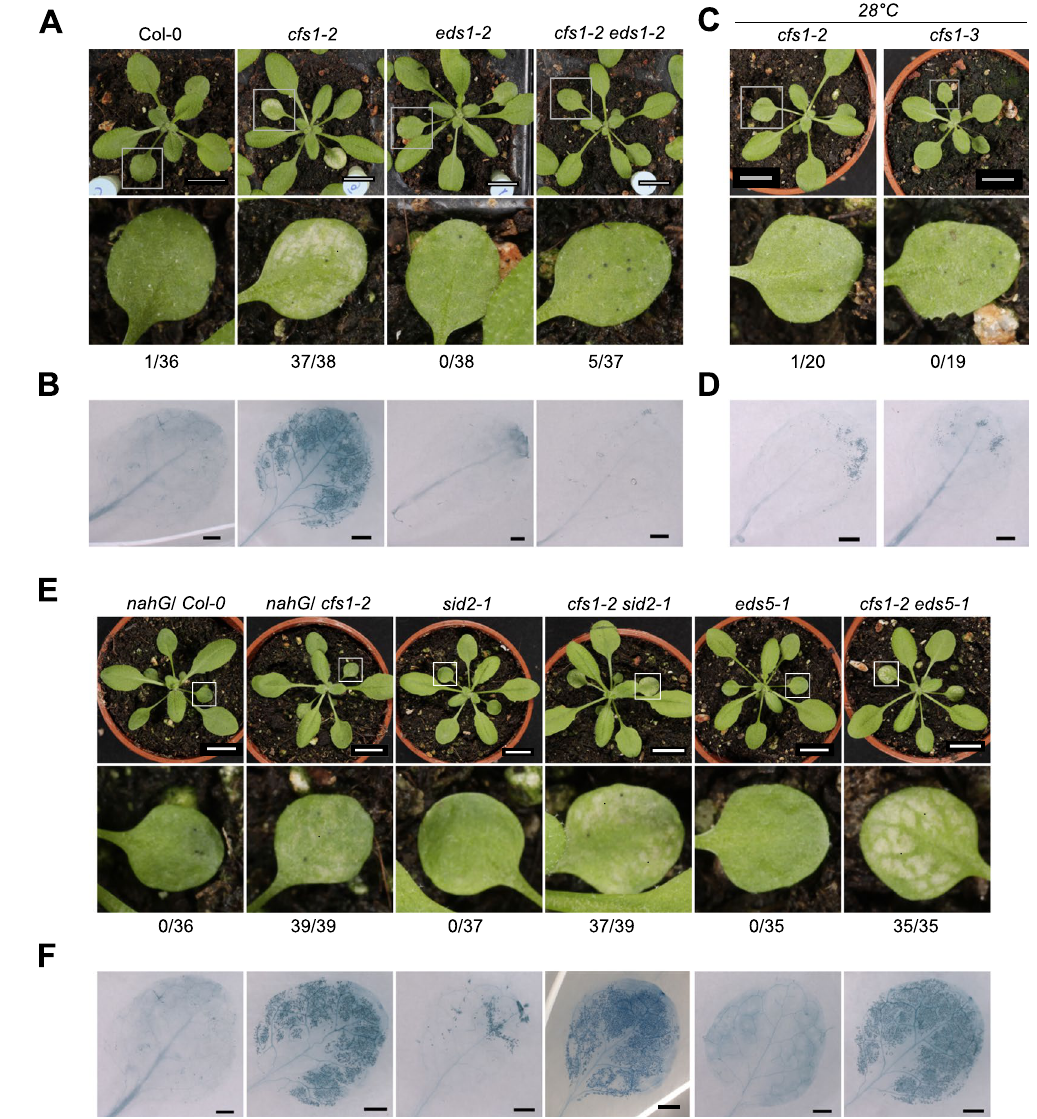
Figure 3. The HR-cell death phenotype in cfs1 is dependent on EDS1-mediated ETI. ( A ) Three-week old Col-0, cfs1-2 , eds1-2 , cfs1-2 eds1-2 . Square indicates leaf 1 or 2 that is digitally magnified below. Scale bars:1 cm. The values below each row represent the number of plants displaying lesions and total number of plants observed from one representative experiment, respectively. ( B ) Trypan blue staining of leaf 1 or 2 from a three-week old plant. The genotype for each image is indicated in the respective panel A. Scale bars: 1 mm. ( C ) cfs1-2 and cfs1-3 plants grown at 28 °C where ETI is rendered inactive. The values below each row represent the number of plants displaying lesions and total number of plants observed from one representative experiment, respectively. ( D ) Trypan blue staining of leaf 1 or 2 of cfs1-2 and cfs1-3 plants grown at 28 °C as in C. Scale bars: 1 mm. ( E ) Three- week old Col-0 plant expressing bacterial nahG , cfs1-2 plant expressing bacterial nahG , sid2-1 , cfs1-2 sid2-1 , eds5-1 and cfs1-2 eds5-1 . Square indicates leaf 1 or 2 that is digitally magnified below. Scale bars: 1 cm. The values below each row represent the number of plants displaying lesions and total number of plants observed from one representative experiment, respectively. ( F ) Trypan blue staining of the first and second leaf from a three-week old plant. The genotype of each image is indicated in the respective panel C. Scale bars:1